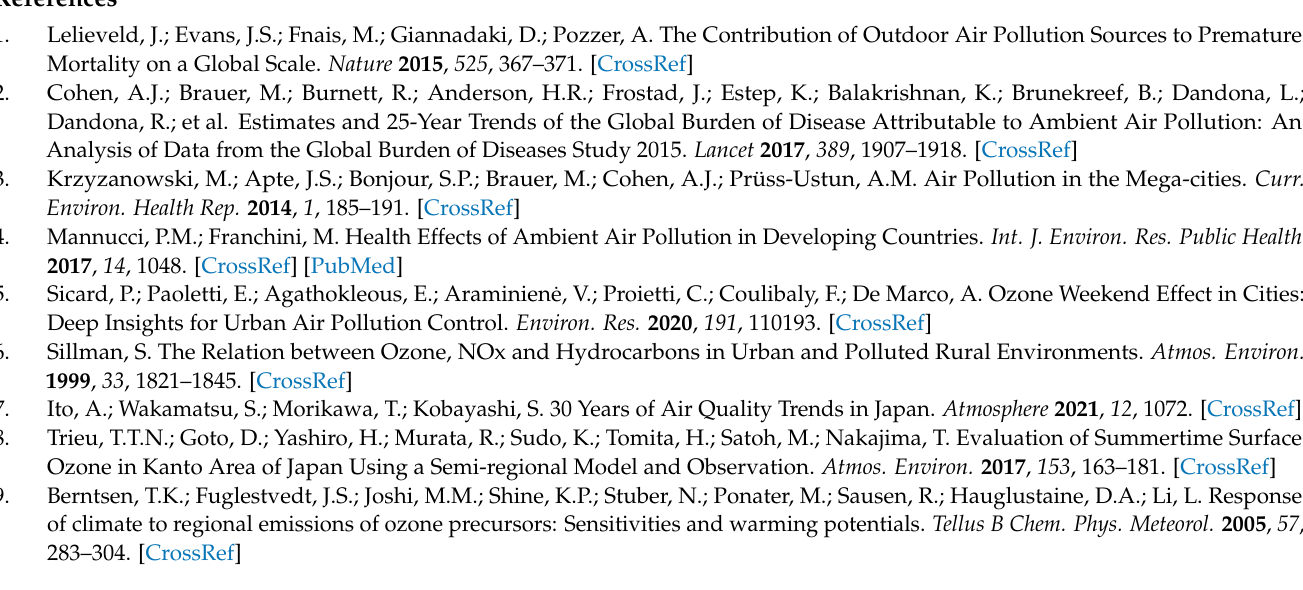
Table S1: Pattern analysis classification results of ADMER-pro, with a 24% of occurrence frequency for the ozone season in 2016; Table S2: Parameters used for the benefit assessment with BESystem. References [39,40,43,46] are cited in the Supplementary